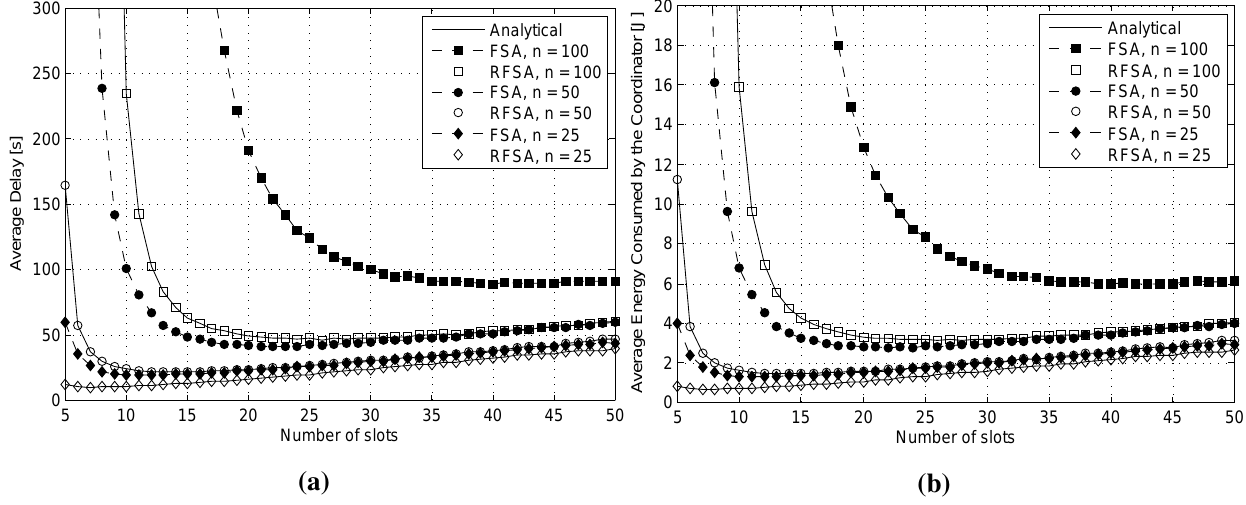
Figure 4. ( a ) Average delay (in seconds) required to terminate a data collection round over the frame length; and ( b ) average energy consumed by the coordinator in a data collection round over the frame